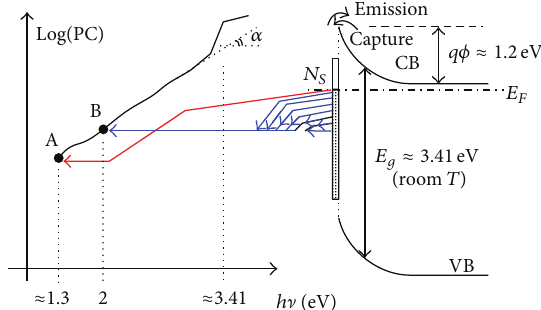
Figure 2: Diagram linking photoconductance signal (log axis) to photon energy for Device no. 1, whose band diagrams are shown in Figure 1. The PC signal at point A is due to electrons emitted from SE close to the quasi-Fermi level 𝐸 𝐹 , while the PC signal at point B accumulates the emissions of electrons trapped at SEs covering a band between 𝐸 𝐹 and 2eV below the CB (see the text).